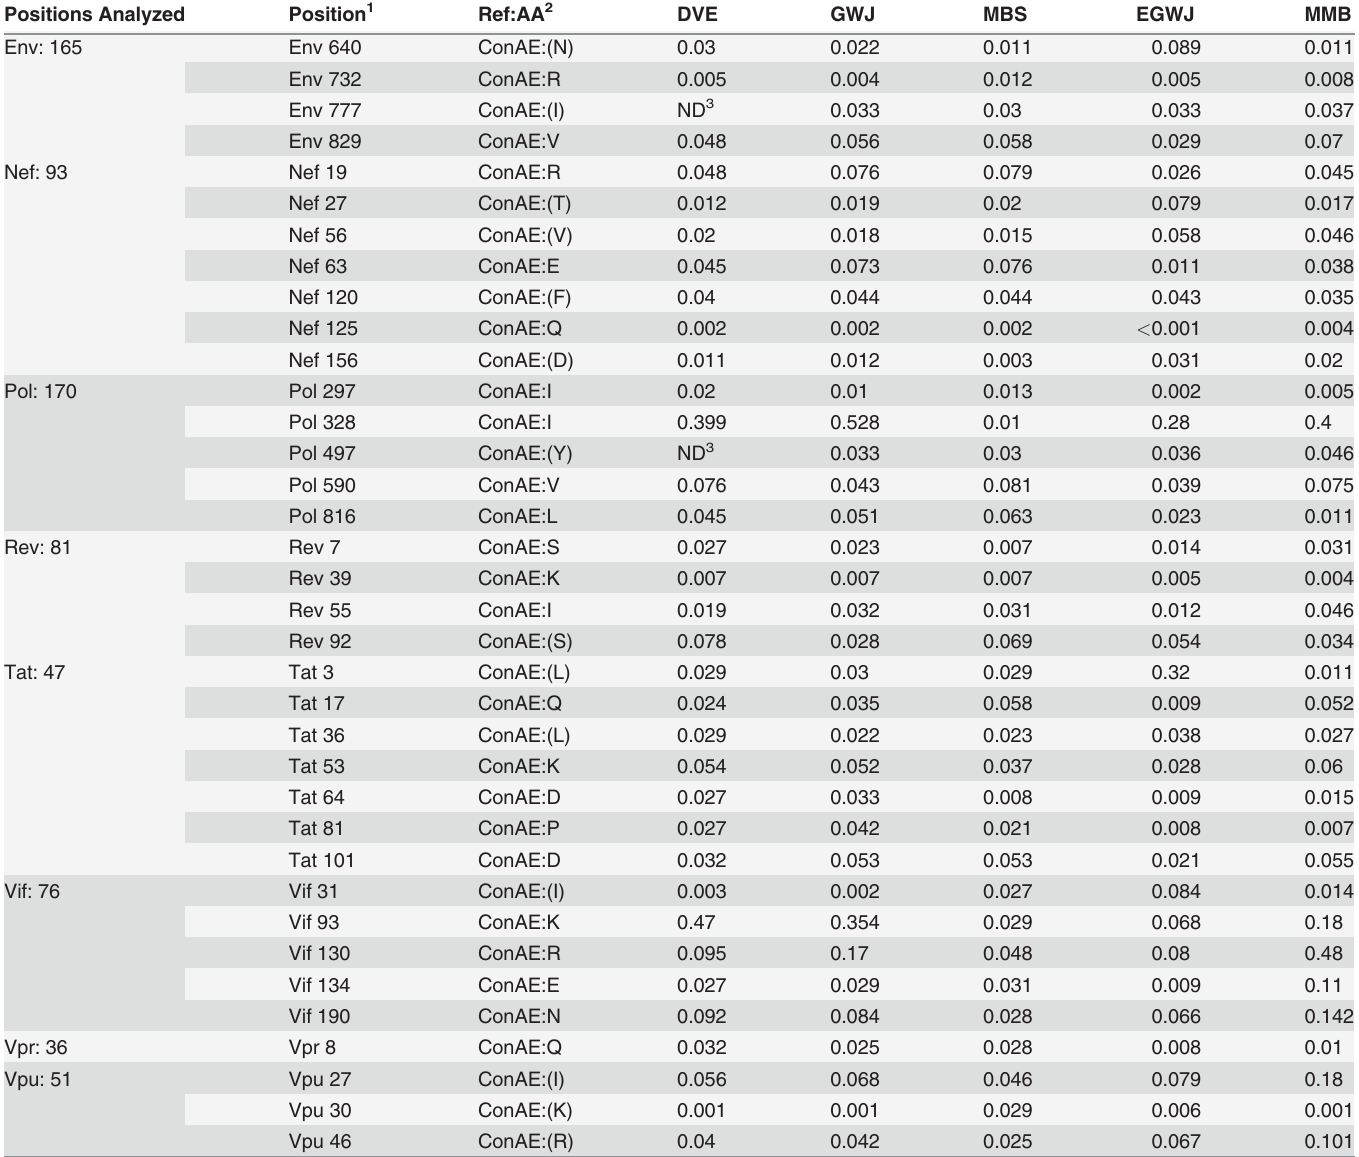
Table 2. Signature sites in non-vaccine proteins: 2-sided unadjusted p-values calculated by fi ve methods. Positions